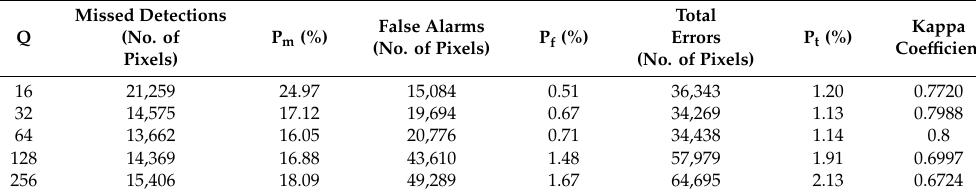
Table 1. Quantitative experimental results under different Q values.